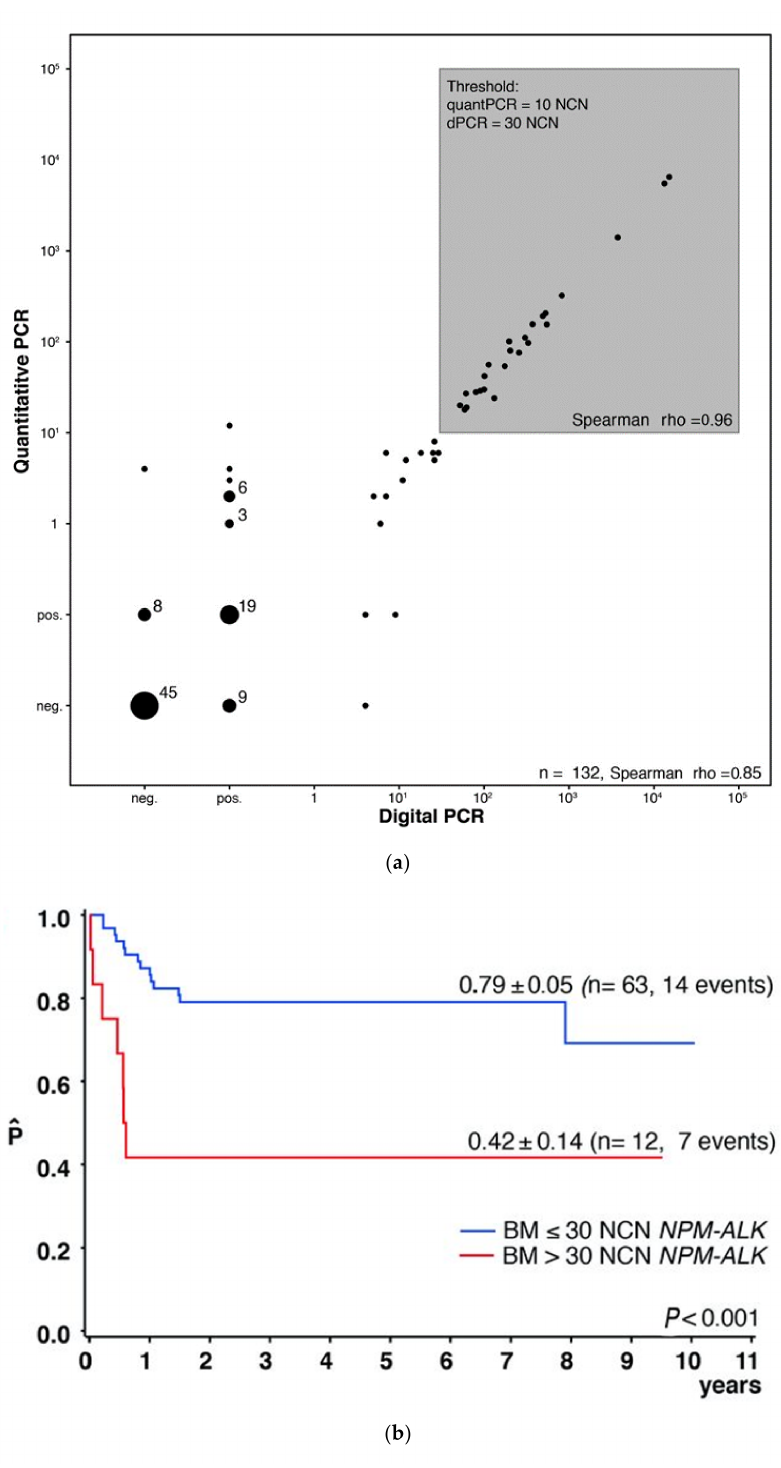
Figure 2. Quantification of minimal disseminated disease by digital PCR for NPM1-ALK fusion transcripts in patients with anaplastic large cell lymphoma. ( a ) Correlation of quantification of minimal disease in blood or bone marrow of patients with anaplastic large cell lymphoma measured by RQ-PCR or digital PCR for NPM1–ALK . ( b ) Five-year event-free survival (EFS) of 75 children with NPM-ALK-positive anaplastic large cell lymphoma according to minimal disseminated disease in bone marrow quantified by digital PCR using a cut-off of 30 copies NPM1-ALK/104 copies ABL. (from Damm-Welk et al.,